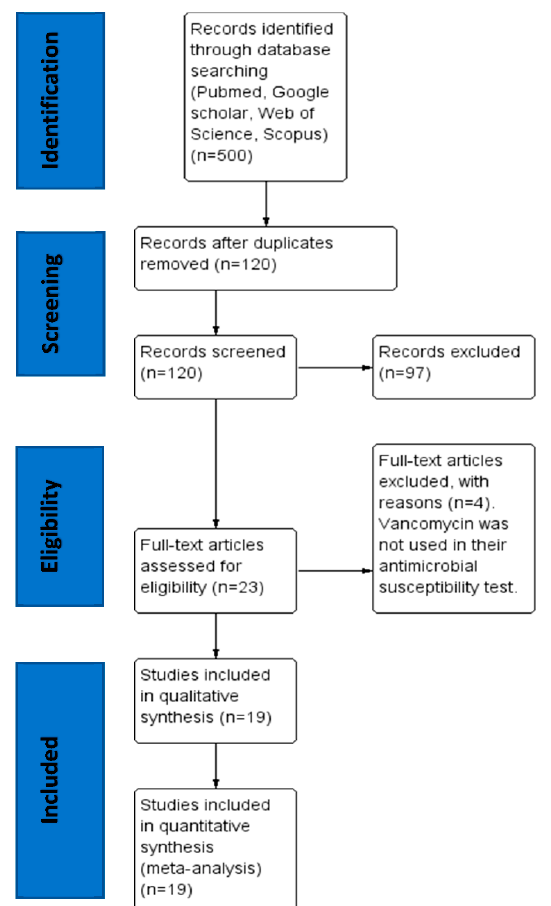
Figure 1. PRISMA flow diagram for the selection of eligible articles included in the study.